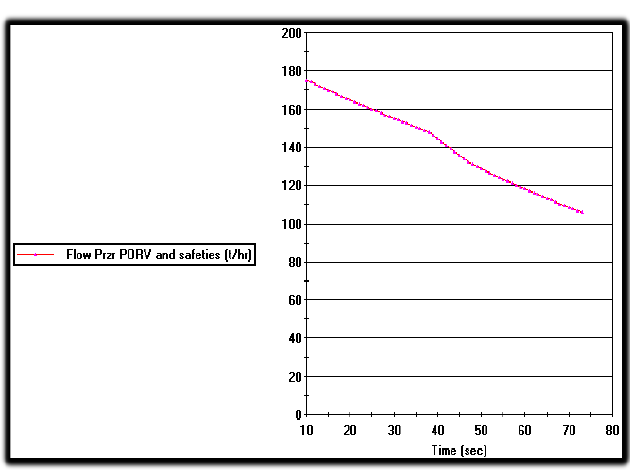
Fig. 21. Transient pressurizer PORV flow under inadvertent opening of pressurizer safety